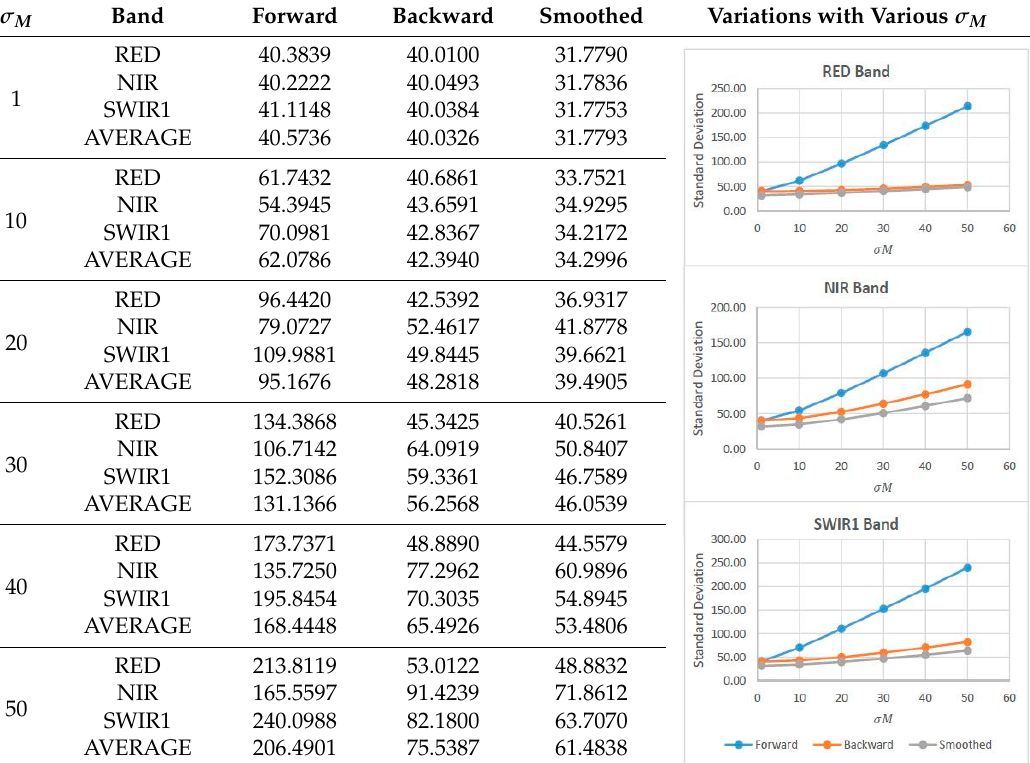
Table 4. Mean of prediction uncertainties (standard deviations, pixel value scaled by 10,000) estimated by PSRFM with an empirically fixed priori pixel uncertainty of σ R = 40 for input Landsat images and various priori pixel uncertainties σ M ranged from 1 to 50 for input MODIS images. Forward Backward Smoothed (cid:2252)